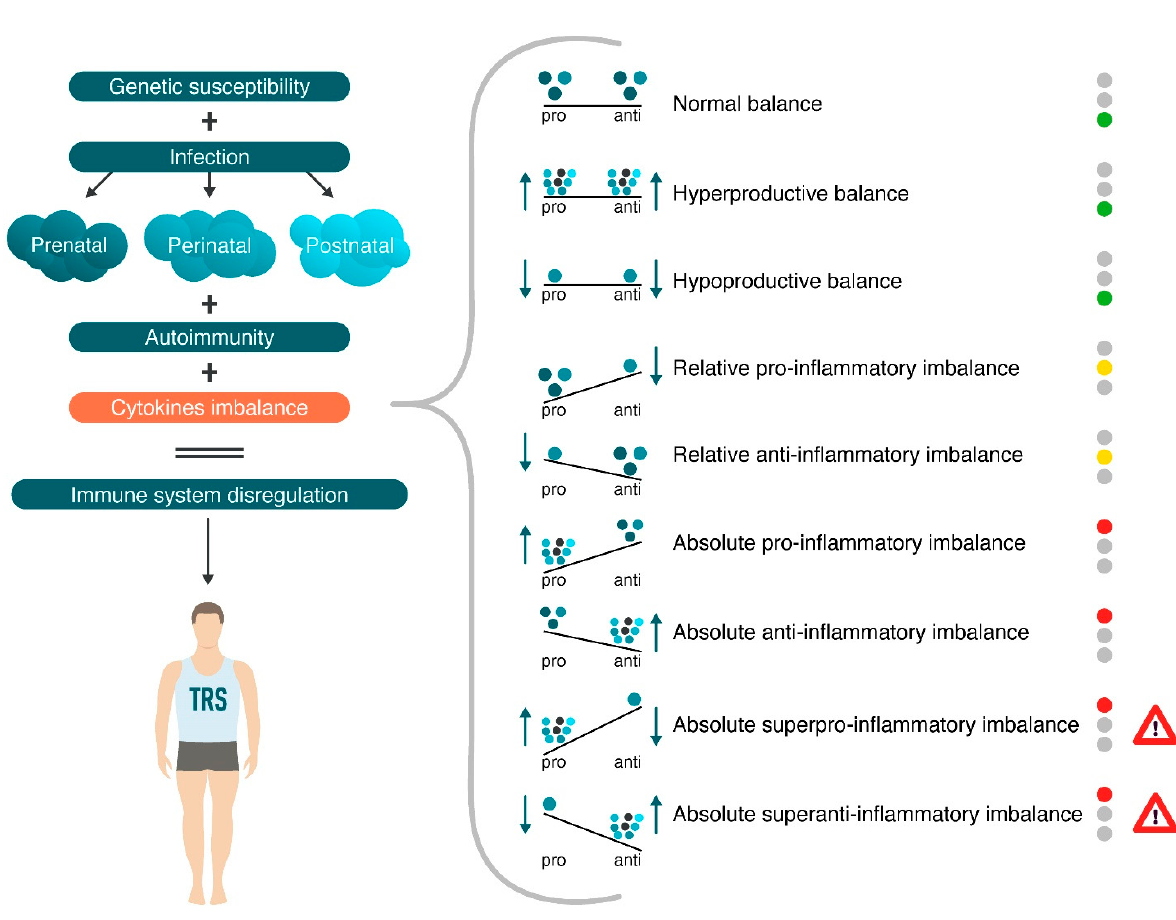
Figure 4. Potential role of normal and abnormal cytokine levels in the cytokine imbalance as a biomarker of treatment-resistant schizophrenia (TRS). Note: green—low risk; yellow—middle risk; red—high risk; red + attention sign—very high risk.